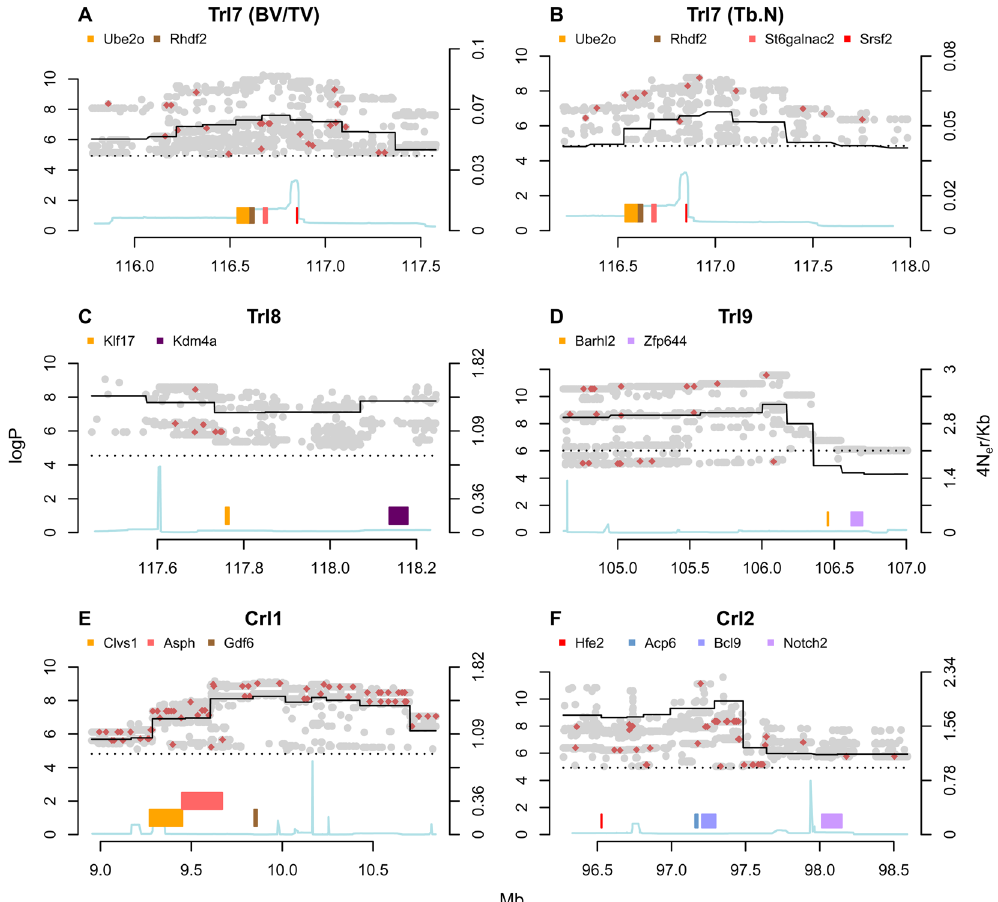
Figure 4. Merge analysis. The x-axis represents the position on the genome in Mb; the left y-axis represents the log P score; the right y-axis represents the recombination rate scale; colored bars are genes (note that only strong putative candidate genes are shown; readings below log P = 4 are omitted for brevity); the cyan line denotes the recombination rate; the black continuous line denotes the pre-merge test result; the dashed line denotes the 99% permutation threshold. (A–F) Trl7 of BV/TV, Trl7 of Tb.N, Trl8 of Tb.Th, Trl9 of Tb.Sp, Crl1 of Ct.Th, and Crl2 of vBMD,